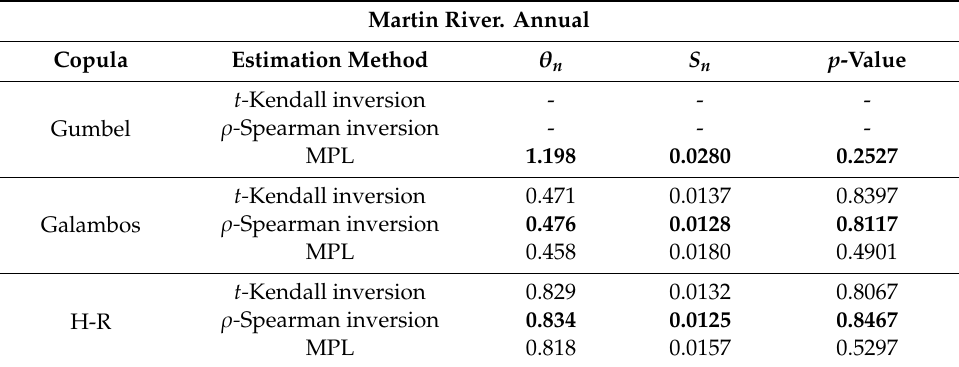
Table 6. Estimated copula values for di ff erent methods. Annual.